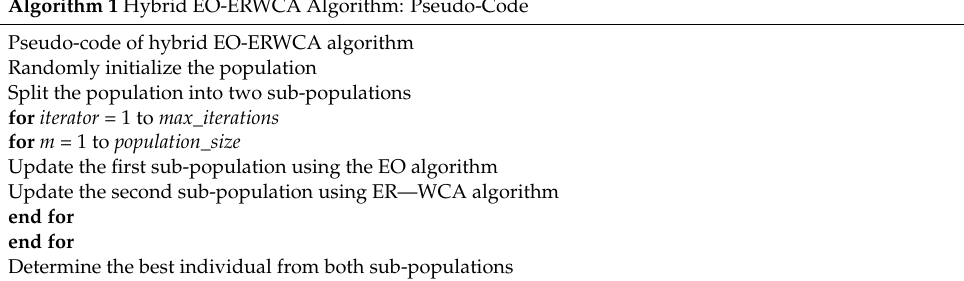
Algorithm 1 Hybrid EO-ERWCA Algorithm: